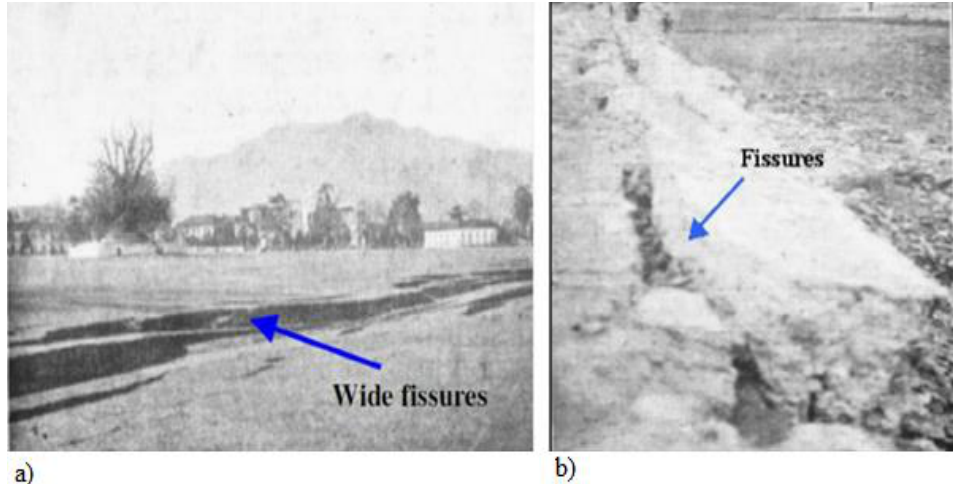
Figure 1. Liquefaction and ground fissures in the ( a ) Tundhikhel and ( b ) Nayabazar areas during the 1934 Nepal–Bihar earthquake (Adapted from ref. [3]).